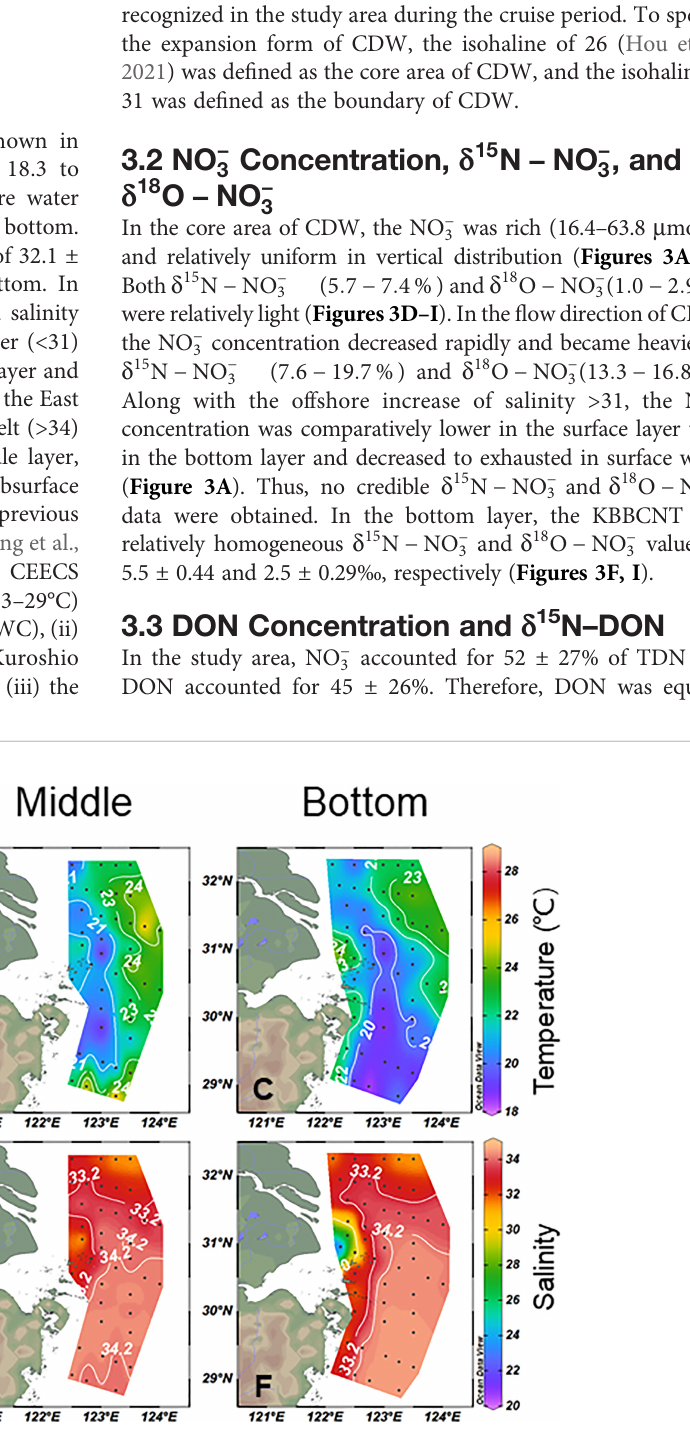
FIGURE 2 | Horizontal temperature (A – C) and salinity (D – F) distributions for surface, middle, and bottom water in the study